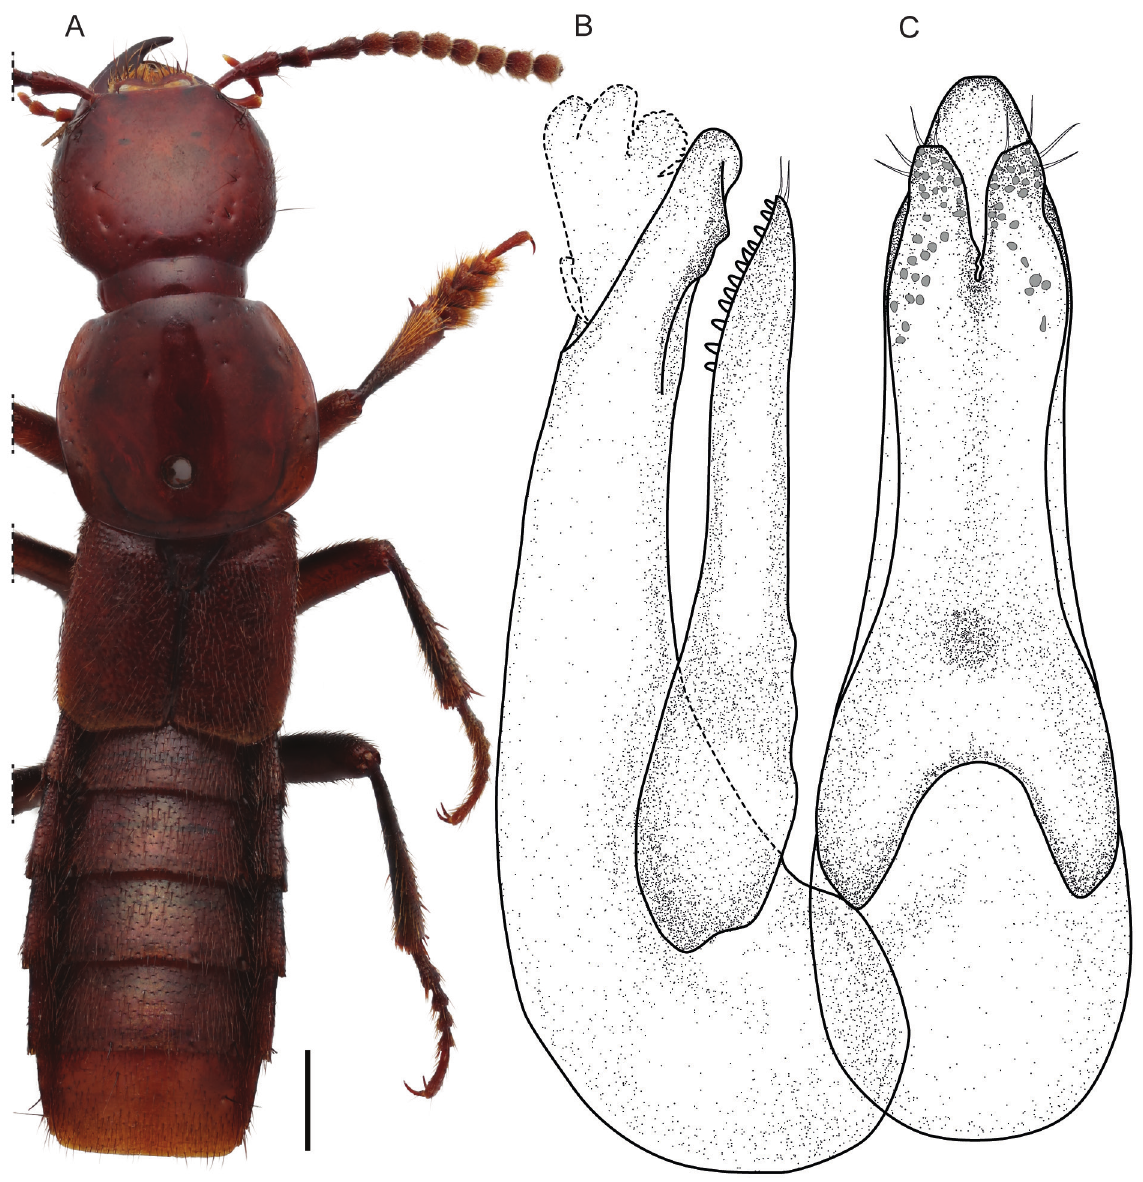
Fig. 11. Quedius adilus sp. nov. A . Habitus, legs and antennae of left side cropped out of image to preserve space. B . Aedeagus in lateral view. C . Aedeagus in parameral view. Scale bar: A = 1